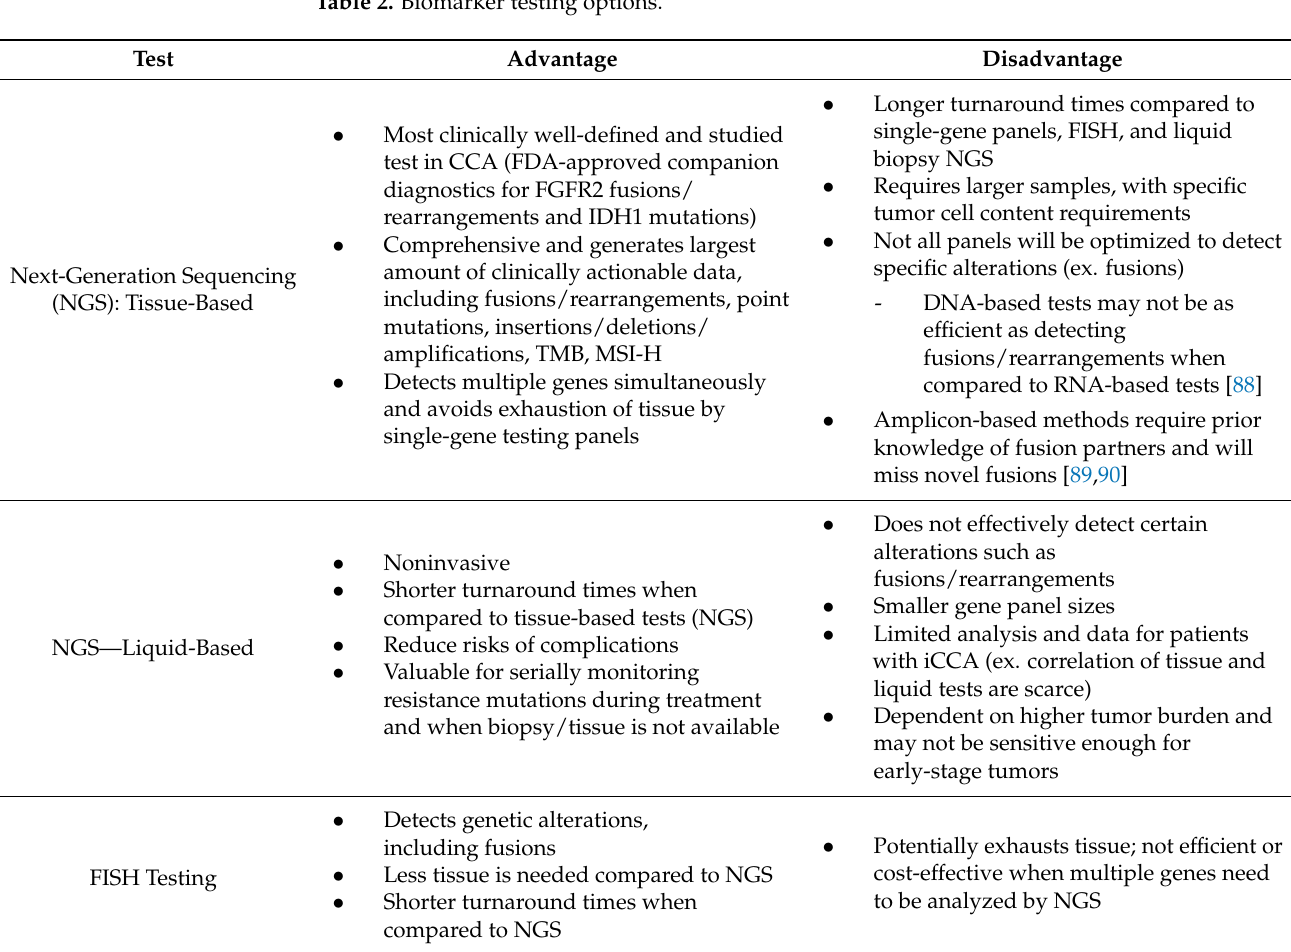
Table 2. Biomarker testing